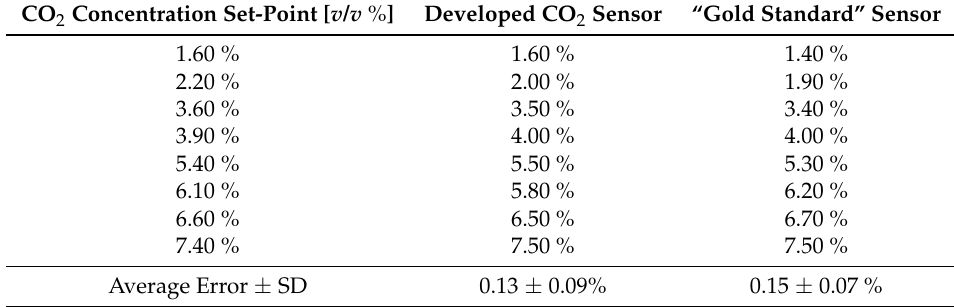
Table 1. Comparison between measurements get by the developed sensor and a “gold standard” device for several CO 2 concentration values. Error is expressed as average value and standard deviation